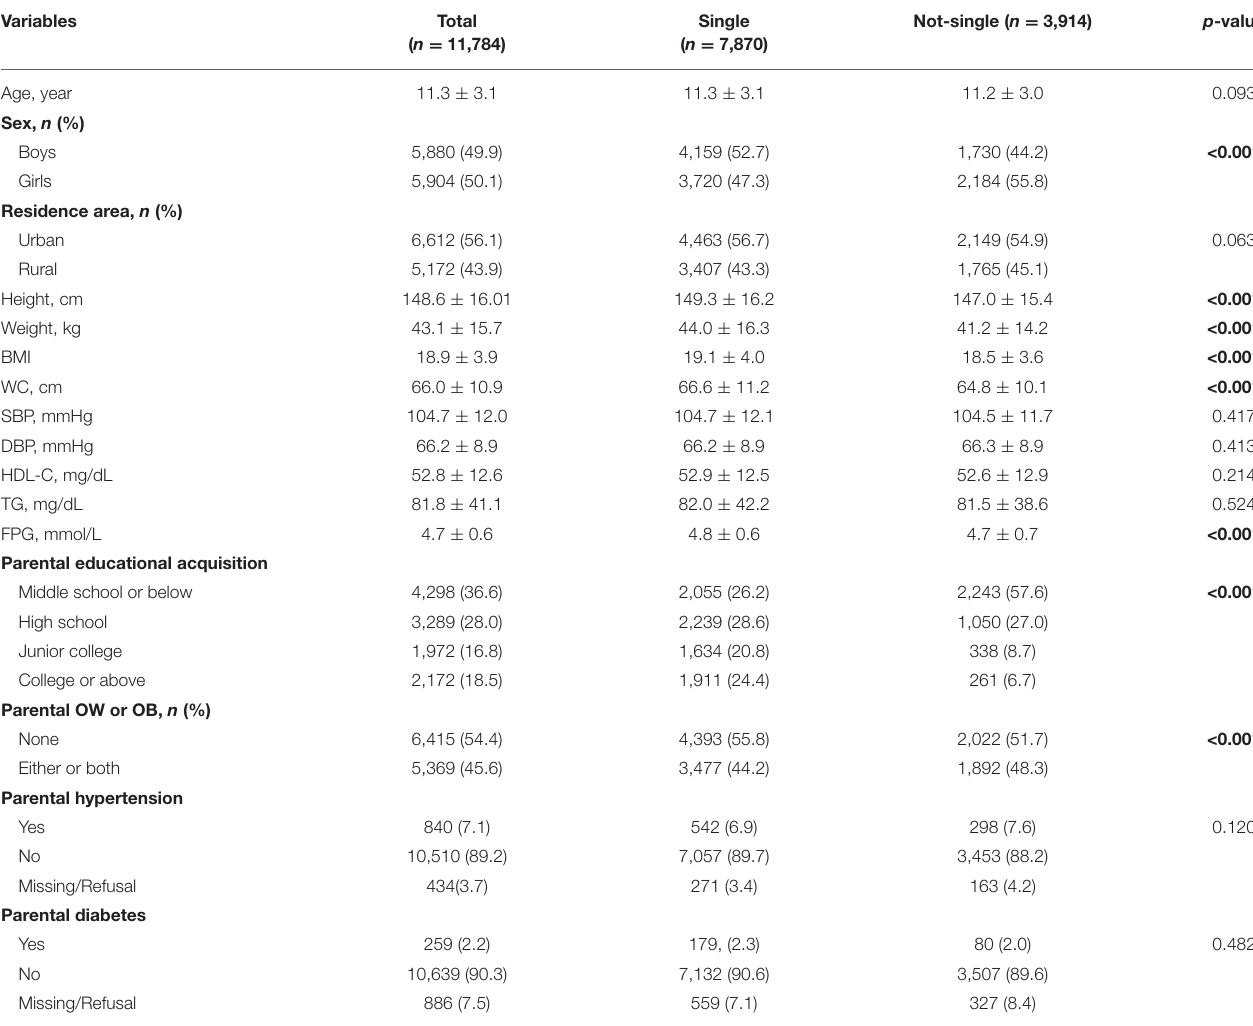
TABLE 1 | Demographic and biochemical characteristics of the participants between single children and not-single children.